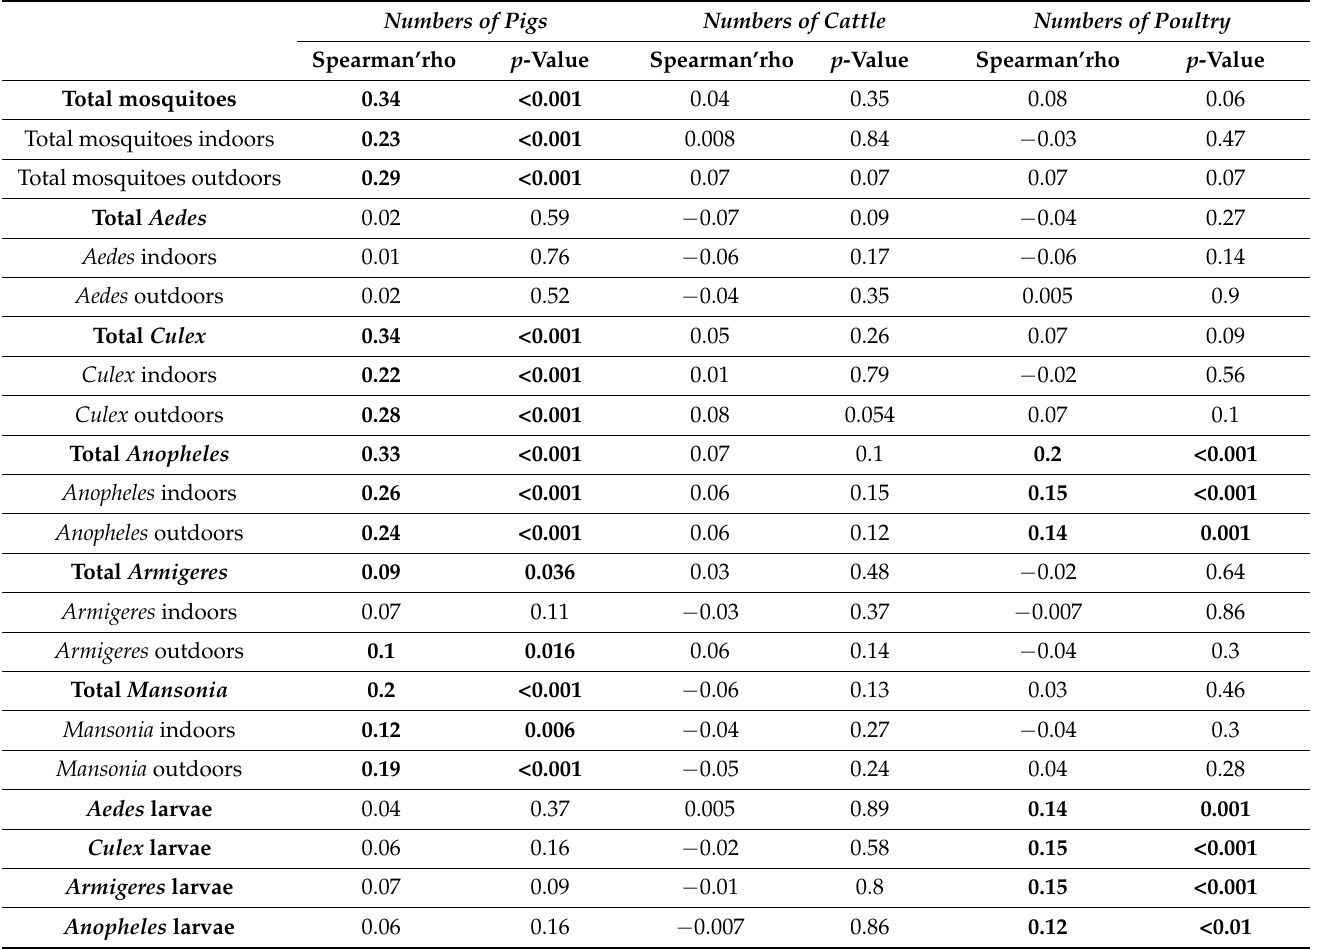
Table 7. Correlation between the quantity of mosquitoes/larvae and the numbers of livestock